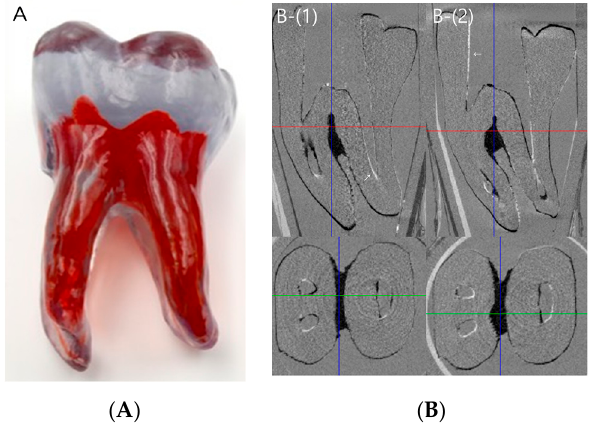
Figure 1. Artificial teeth. ( A ) Artificial molar teeth used in this experiment; ( B ) Superimposition images of the prepared canal spaces before canal obturation. The white line in the canal space (arrow) indicates a difference between samples. (1) The overlapping image of samples 1 and 2. (2) The overlapping image of samples 1 and 3.